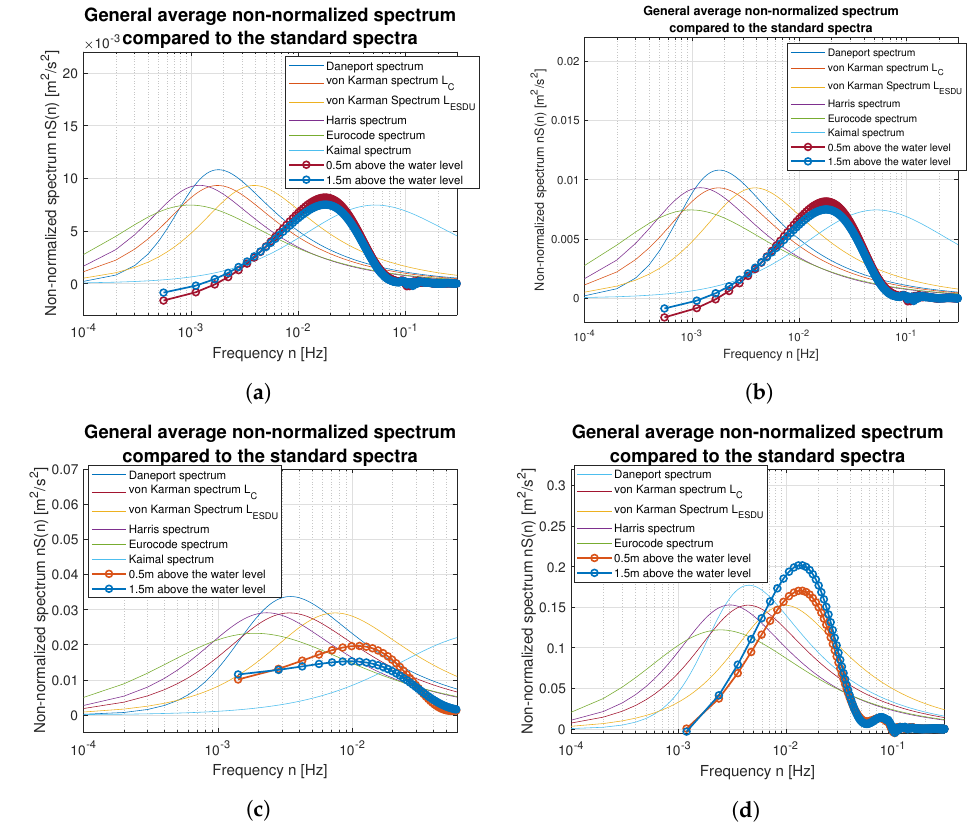
Figure 17. Estimated spectra compared to standard ones: ( a ) Weak wind (3 BFT in ship scale); ( b ) Weak wind (4 BFT in ship scale); ( c ) Medium weak wind (5 BFT in ship scale); ( d ) Medium strong wind (6 BFT in ship